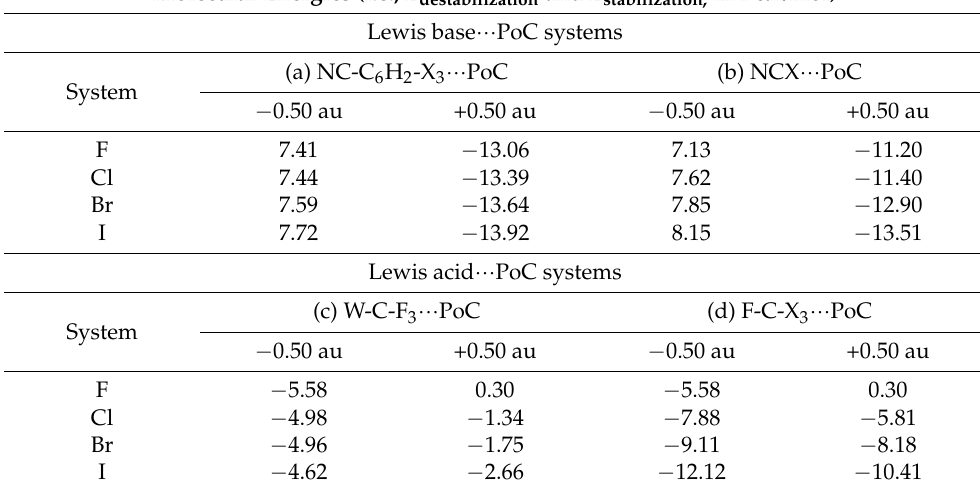
Table 1. Molecular stabilization ( E stabilization ) and destabilization ( E destabilization ) energies of (a)